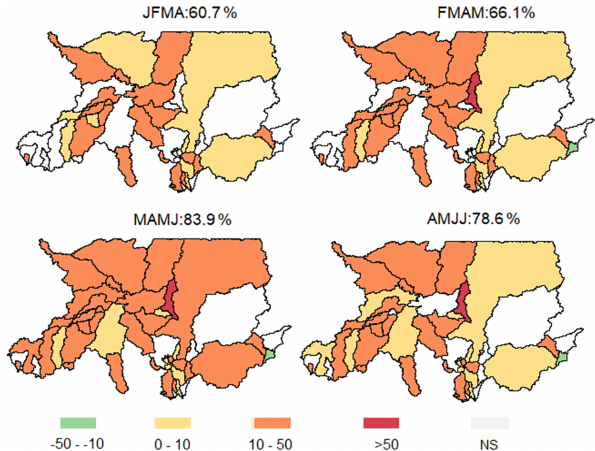
Figure 3. Percentage change of annual maximal discharge per unit change SOI/SLP for stations with significant correlation at